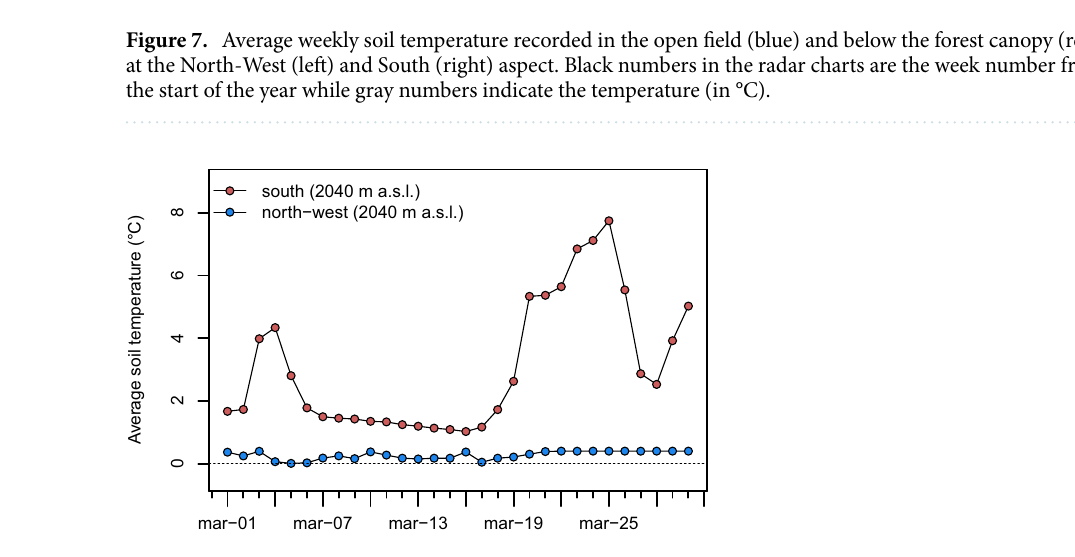
Figure 8. Comparison of average soil near-ground temperature in the open field during March 2017 on north- west (blue) and south-facing slopes